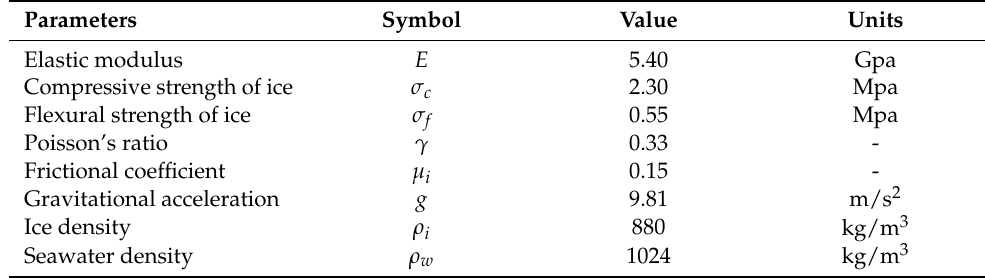
Table 2. The values used for the Araon.